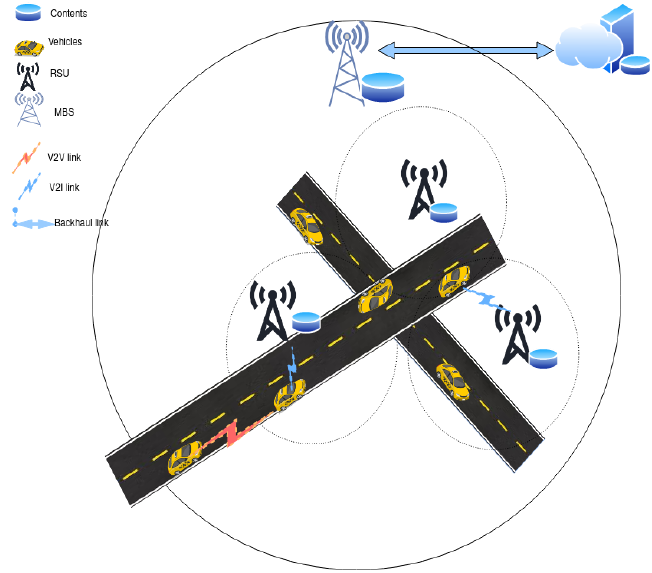
Figure 2. IoV networks scenario.